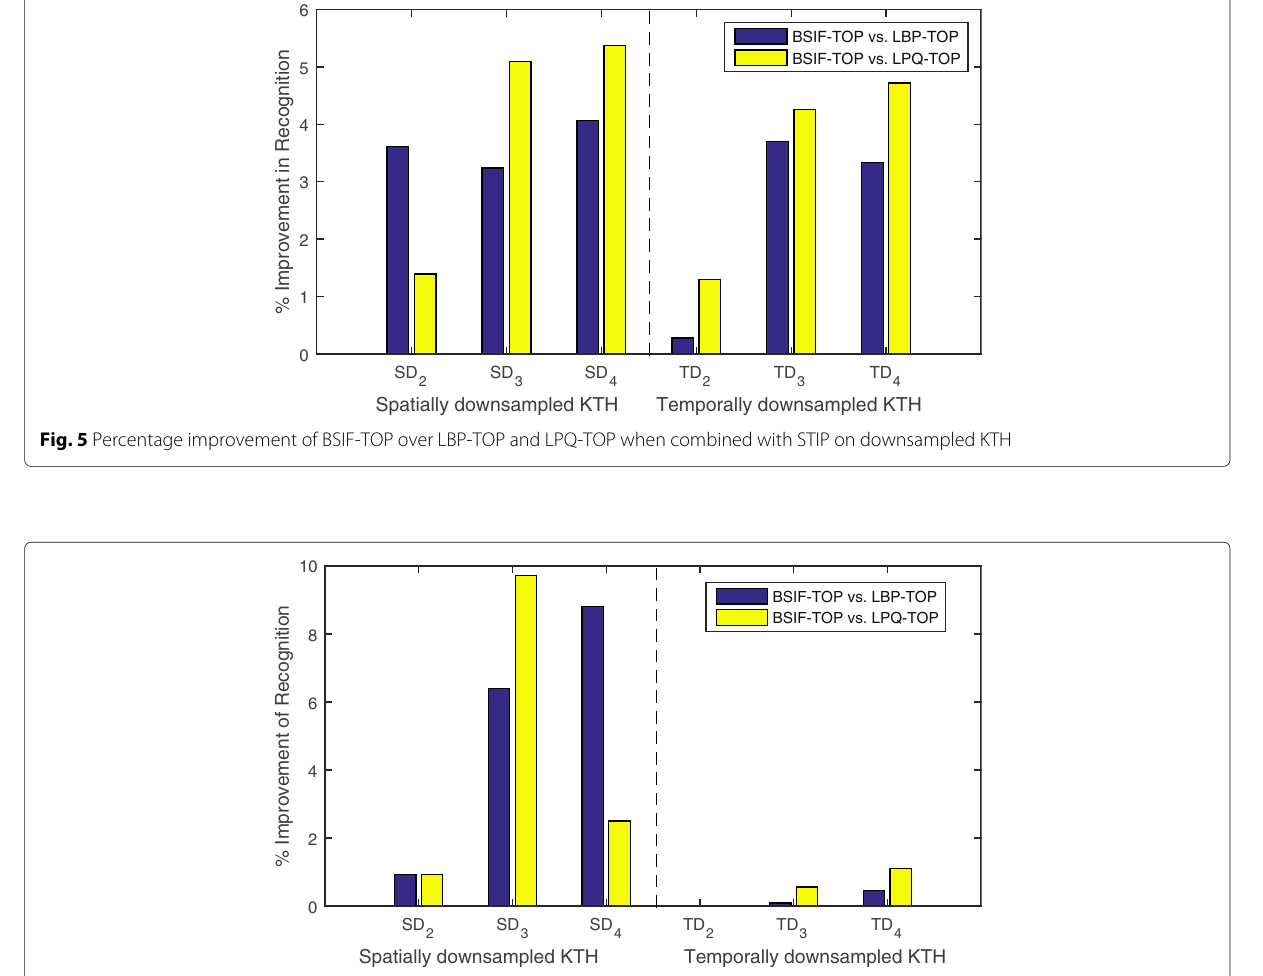
Fig. 6 Percentage improvement of BSIF-TOP over LBP-TOP and LPQ-TOP, when combined with iDT on downsampled